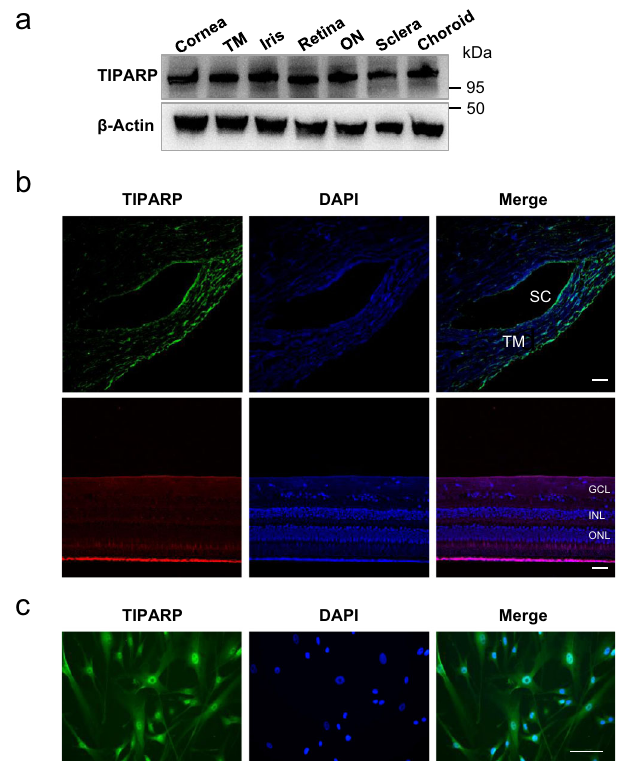
Fig. 1 Expression and distribution of TIPARP in human trabecular meshwork tissues and cells. a TIPARP expression in the human cornea, trabecular meshwork, iris, retina, optic nerve, sclera, and choroid by Western blot. b Immuno fl uorescence of TIPARP showed positive staining in the human trabecular meshwork, Schlemm ’ s canal and retina. Scale bar = 25 μ m. c In human trabecular meshwork cells, immuno fl uorescence staining of TIPARP indicated nuclear and cytoplasmic localization. Scale bar = GCL ganglion cell layer, INL inner nuclear layer, ONL outer nuclear